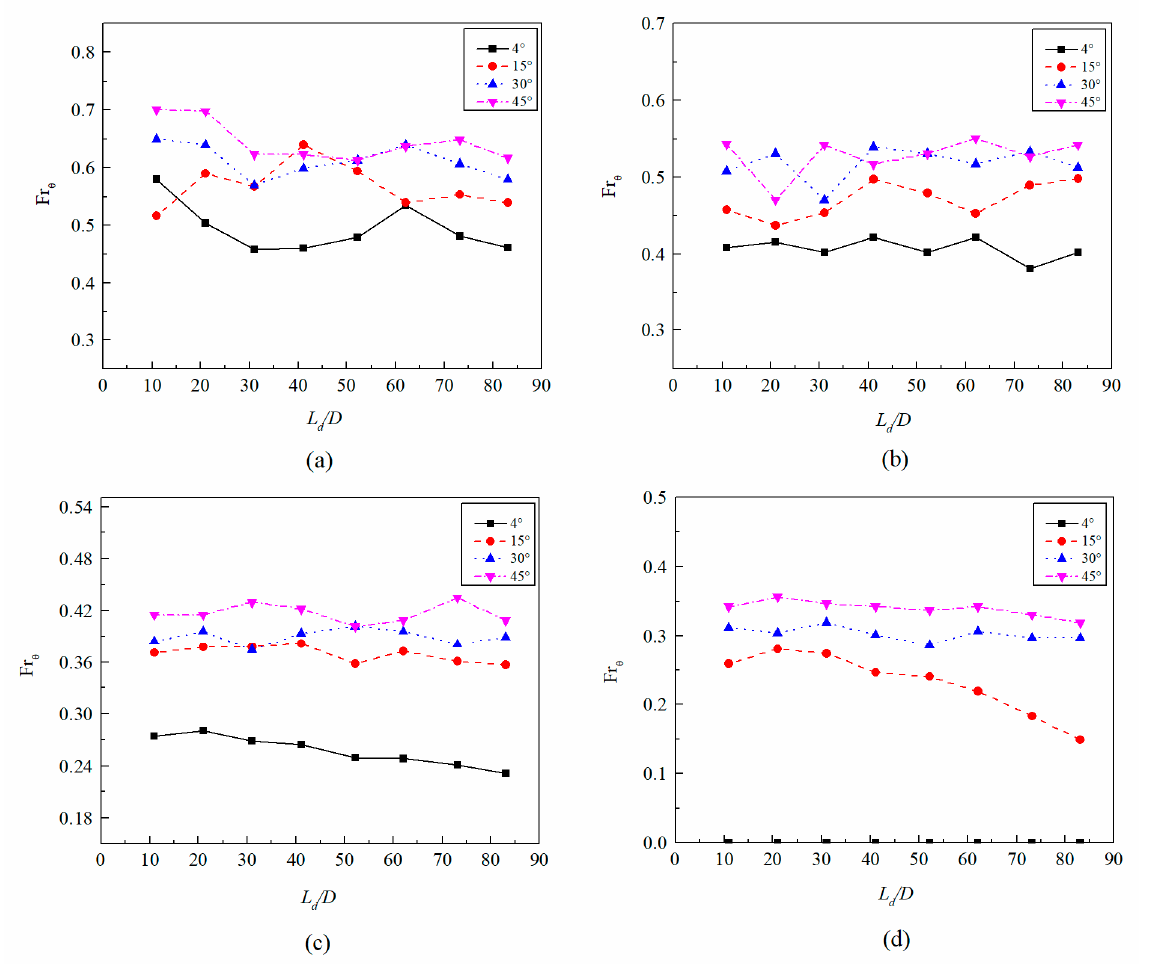
Figure 22. Drift velocity at different position of the pipe. ( a ) 10 lb/bbl BW; ( b ) 30 lb/bbl BW; ( c ) 45 lb/bbl BW; ( d ) 48.5 lb/bbl BW.